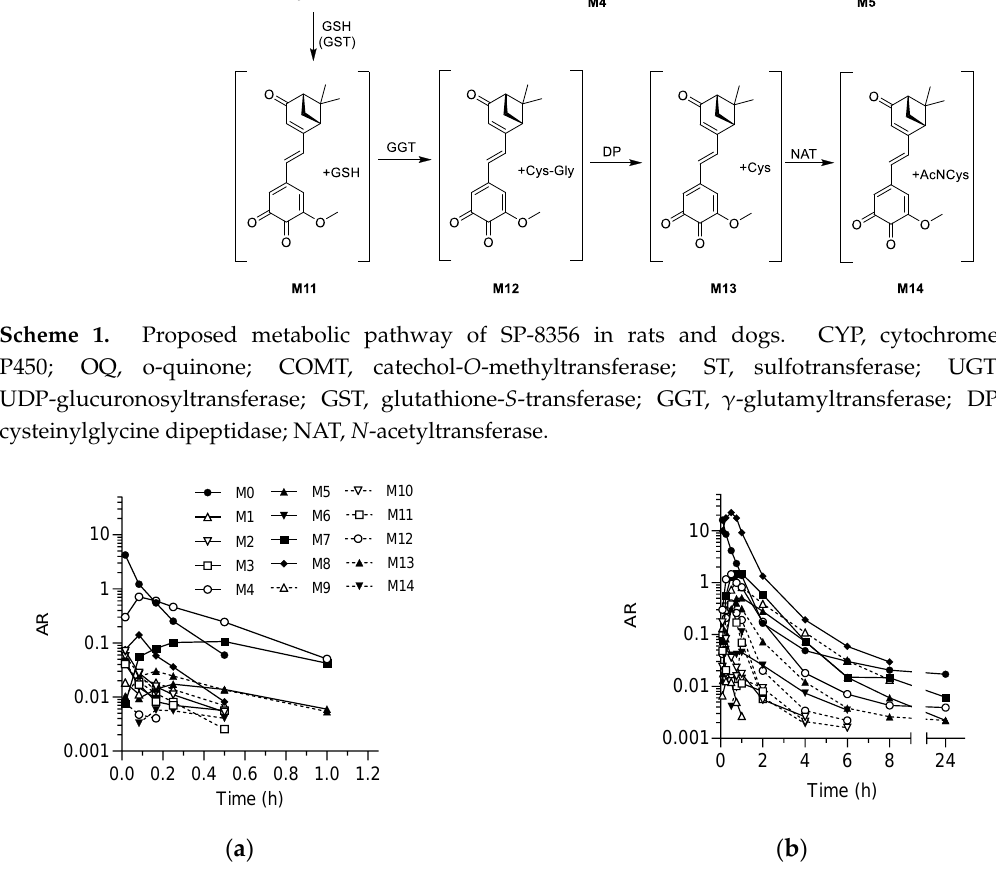
Figure 2. Time courses of SP-8356 and putative metabolites in pooled plasma following a single i.v. administration of SP-8356 at (20 and 50) mg / kg in ( a ) rats and ( b ) dogs, respectively. The plasma levels are expressed as the AR of the extracted ion chromatograms of metabolites versus the internal standard. Table 3. Plasma exposure of SP-8356 and its putative metabolites detected in rat and dog plasma.